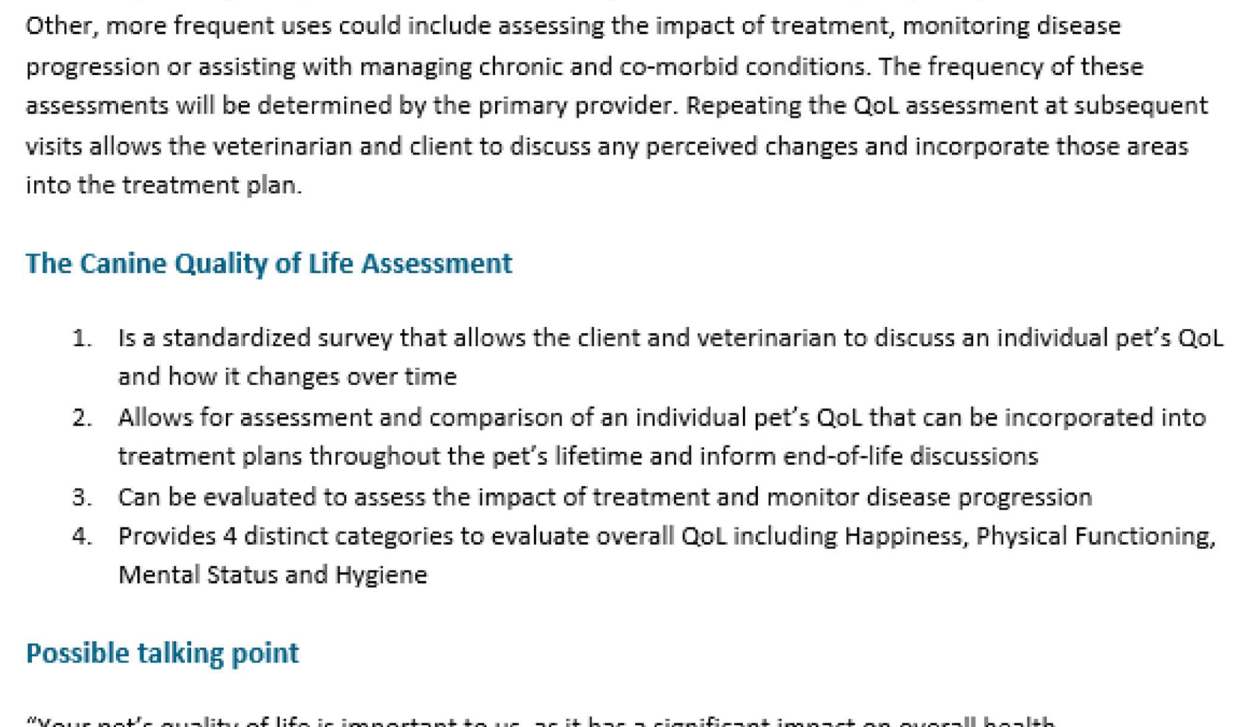
use, QOL scores were summarized but not statistically